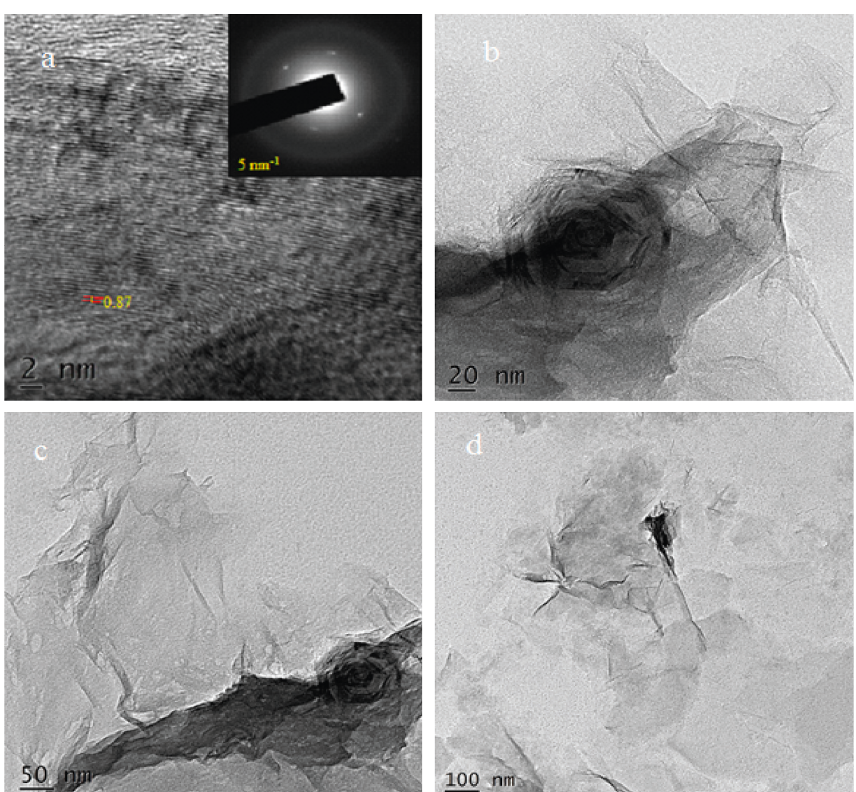
Figure 5: (a–d) TEM image of GO along with EDAX analysis and inset is the selected area electron diffraction (SEAD) pattern of